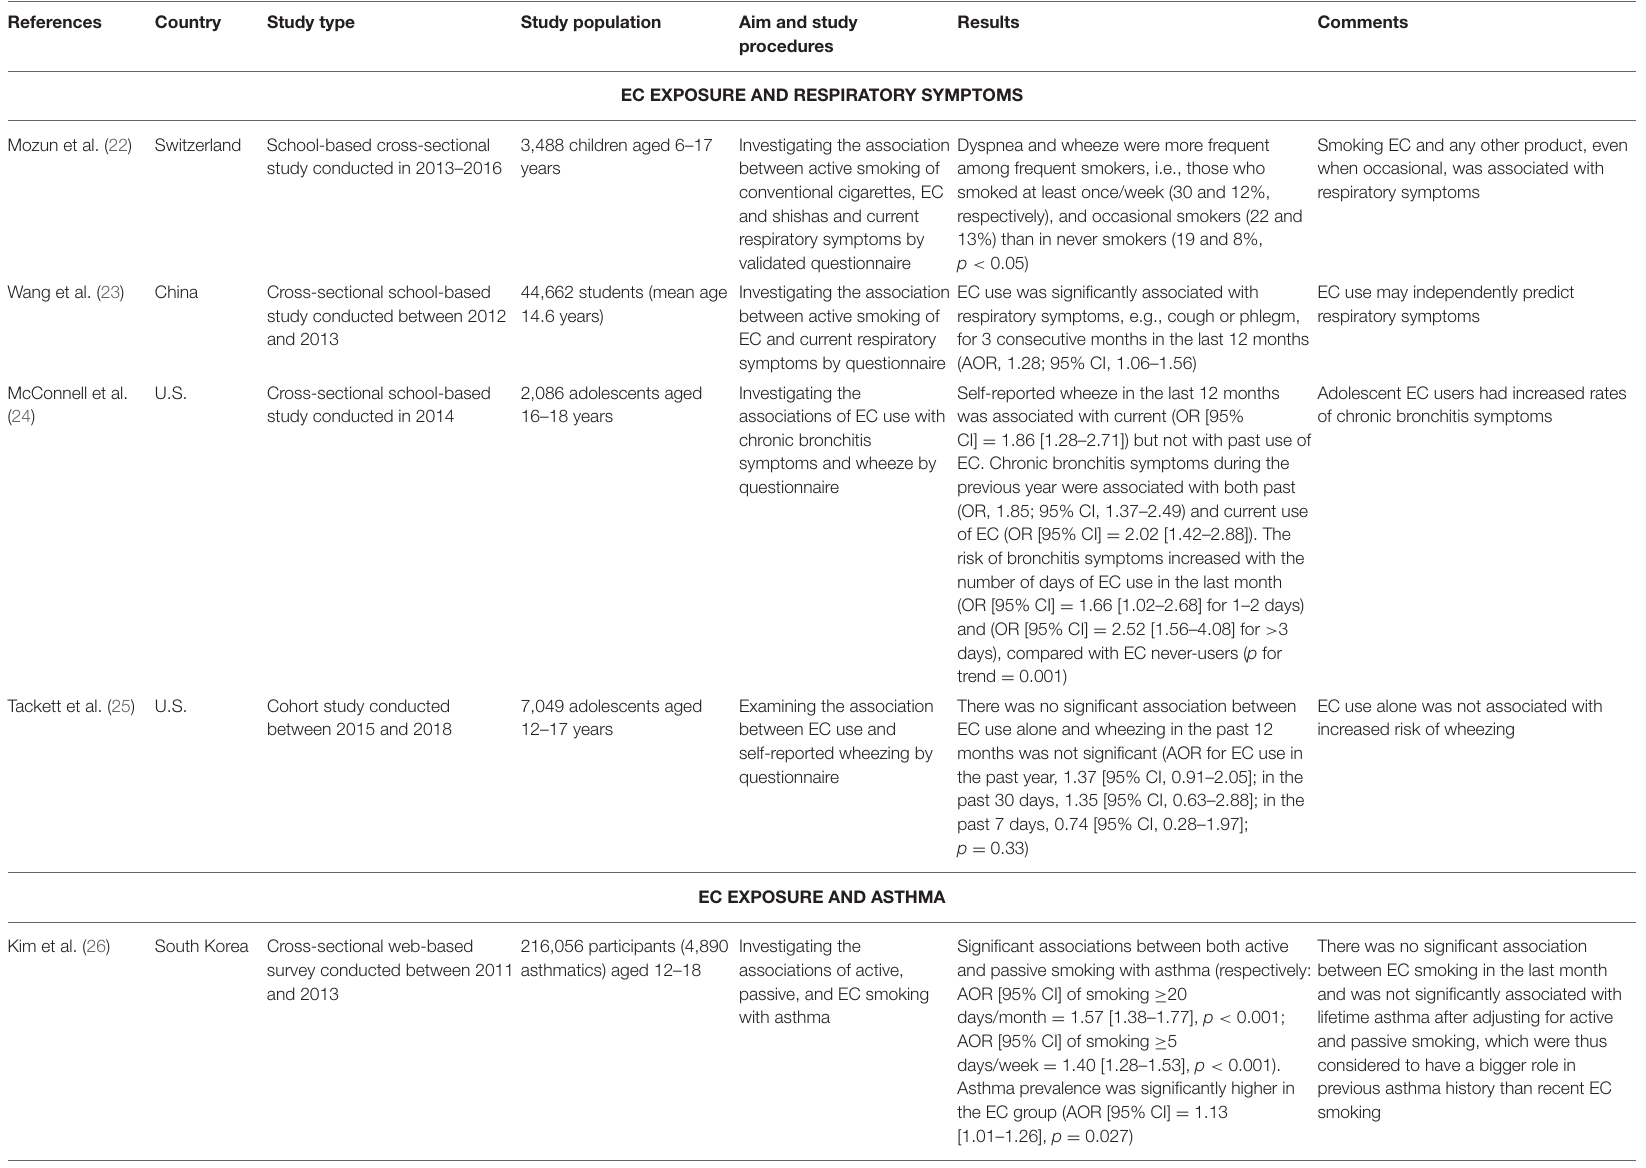
TABLE 1 | Respiratory effects of EC exposure in